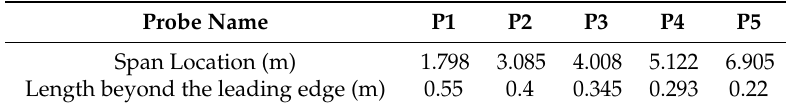
Table 4. Calibration errors of leading-edge probes.